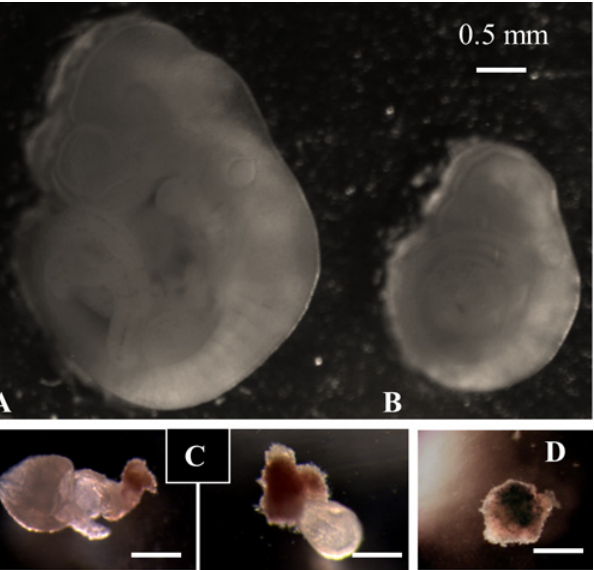
Fig 1. Fetal classification on 9.5 dpc in older C57BL/6 mice. C57BL/6 mice (10 – 17 months of age) were killed on 9.5 dpc. All implants were dissected for determining fetal states. A. A normal 9.5 dpc fetus. B. A retarded littermate. C. Two examples of Grade 1 resorption. D. A Grade 2 resorption. Scale bar = 0.5